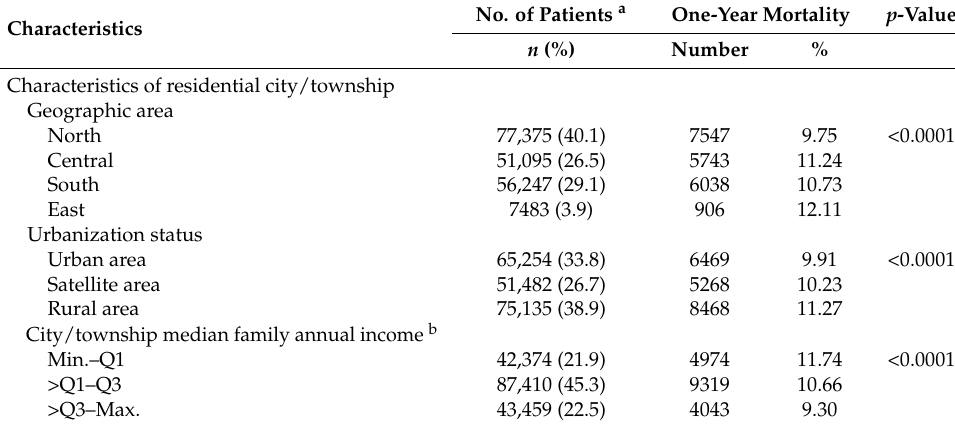
Table 1. Characteristics of the study patients and risk of one-year